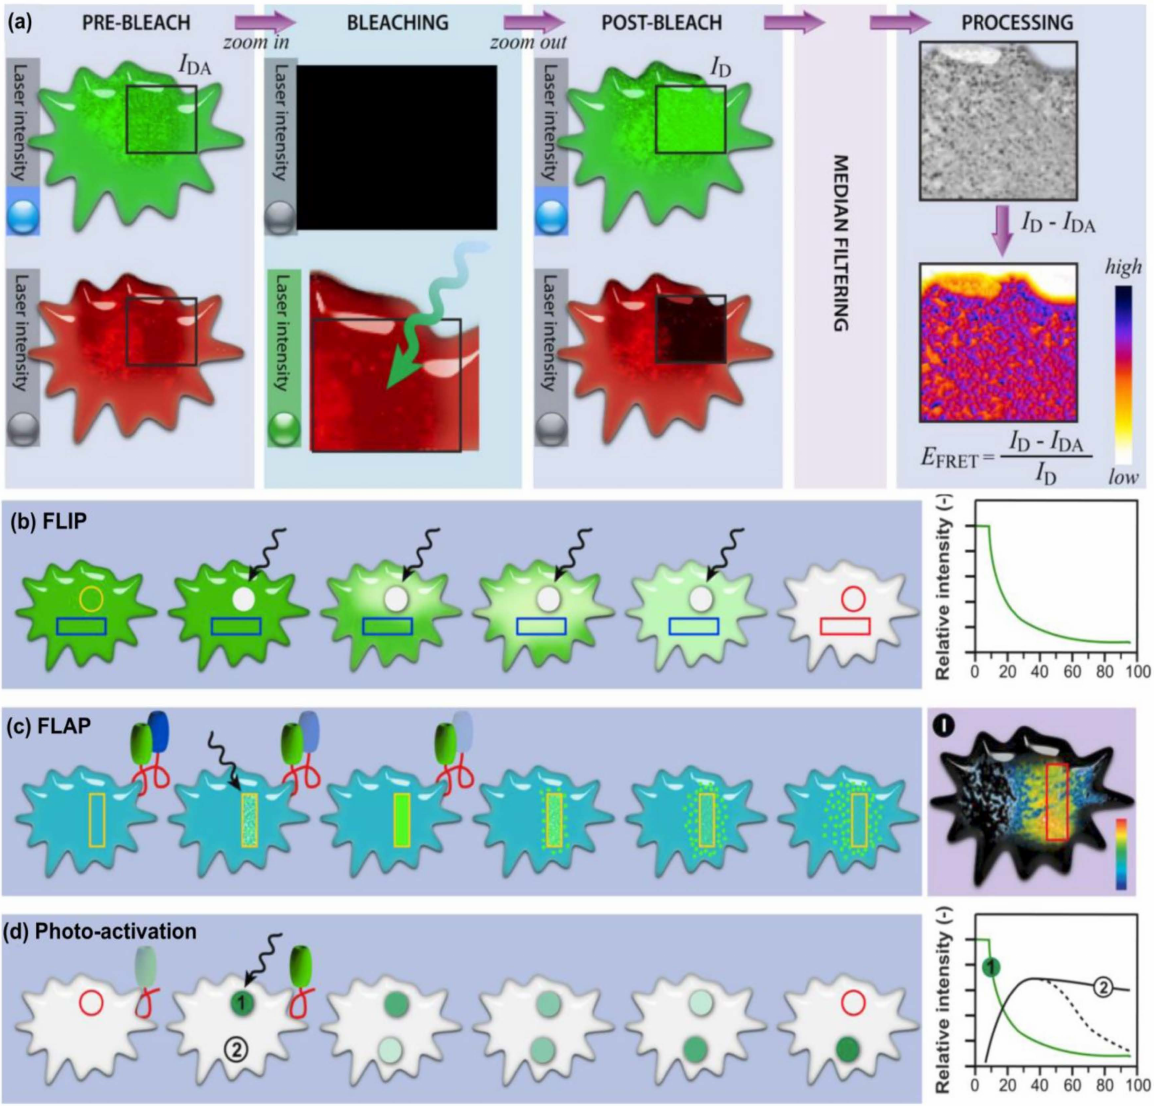
Figure 11. ( a ) workflow of FRET ( b ) Workflow of FLIP, ( c ) workflow of FLAP, ( d ) workflow of Photoactivation. Images reprinted with permission from [123] under creative commons CC BY